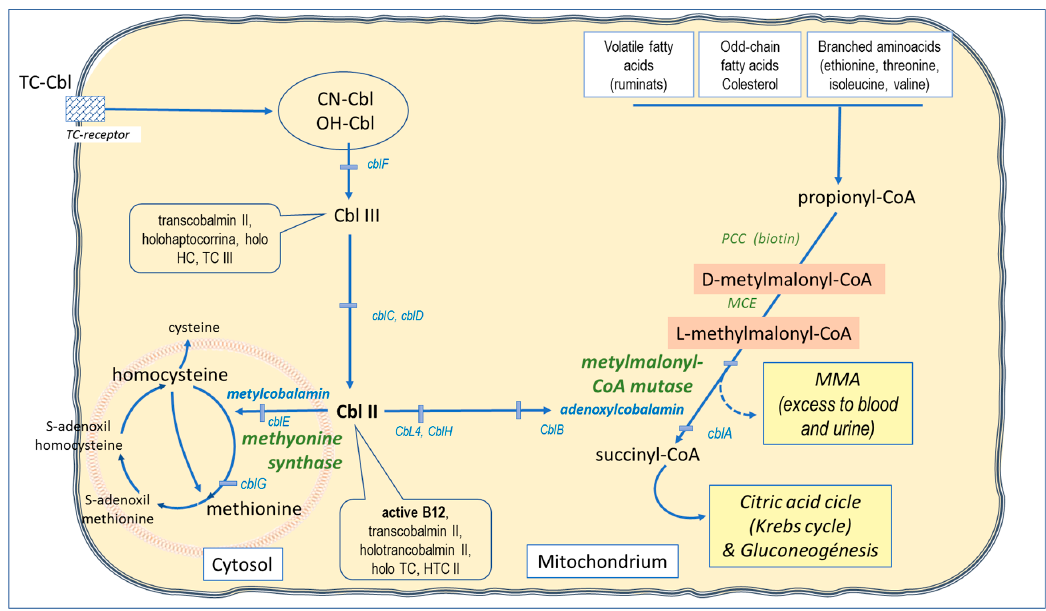
Figure 3. The participation of vitamin B12 in biochemical reactions. Enzymatice systems in which it participates as a coenzyme.